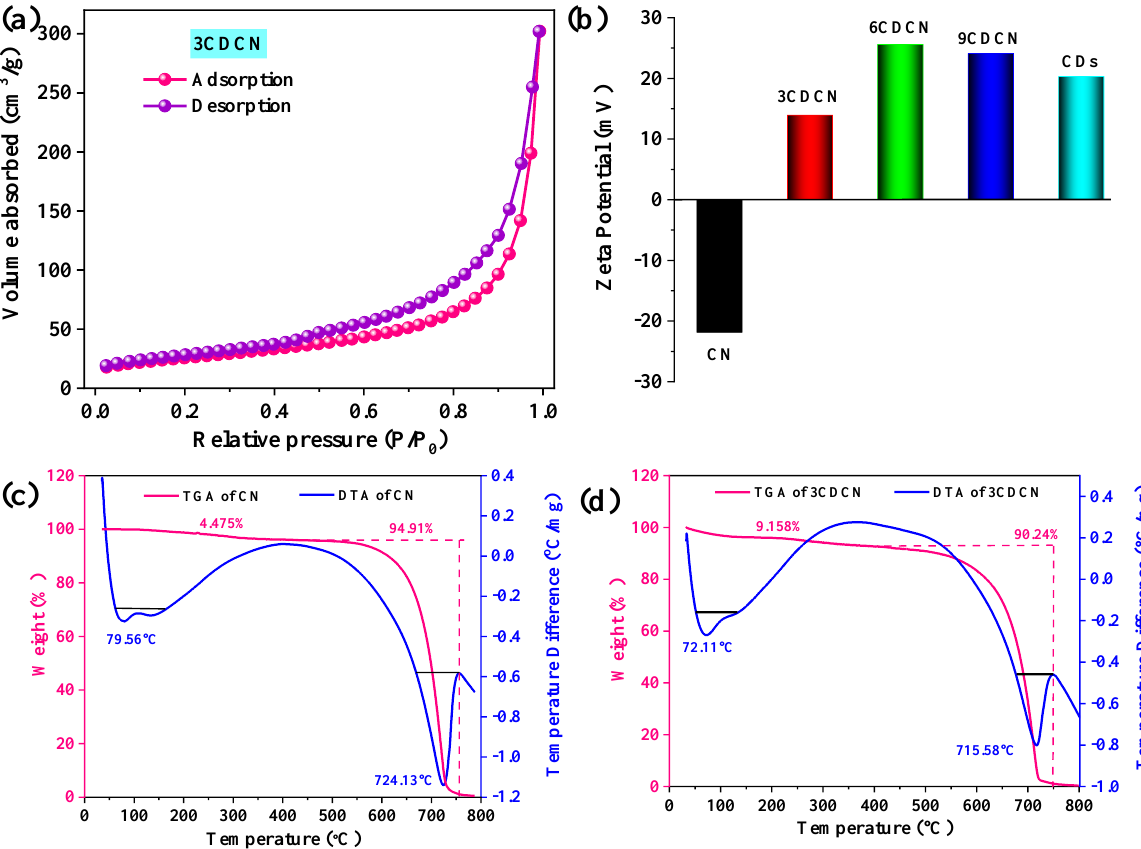
Figure 4. ( a ) BET isotherm of the 3CDCN nanocomposite, ( b ) Zeta potential of CN, 3CDCN, 6CDCN and 9CDCN, CDs and TGA, and the DTA graph of ( c ) CN and ( d ) 3CDCN. The photogenerated charge carrier separation efficiency in semiconductors is fre- quently investigated, using PL emission spectroscopy [60]. The PL emission signal is produced by the combination of excited electrons and holes. Figure 5d depicts the PL emission spectra of the as-prepared photocatalysts, stimulated at 390 nm. A broad emission peak with a center wavelength of about 458 nm, as seen in all CDCN photocatalysts, could be attributed to the band–band PL phenomenon of the photo-induced charge carriers for CN. The 3CDCN, 6CDCN, and 9CDCN composites exhibited significant PL quenching when compared to the CN, due to the effective charge transfer at the heterostructure interface